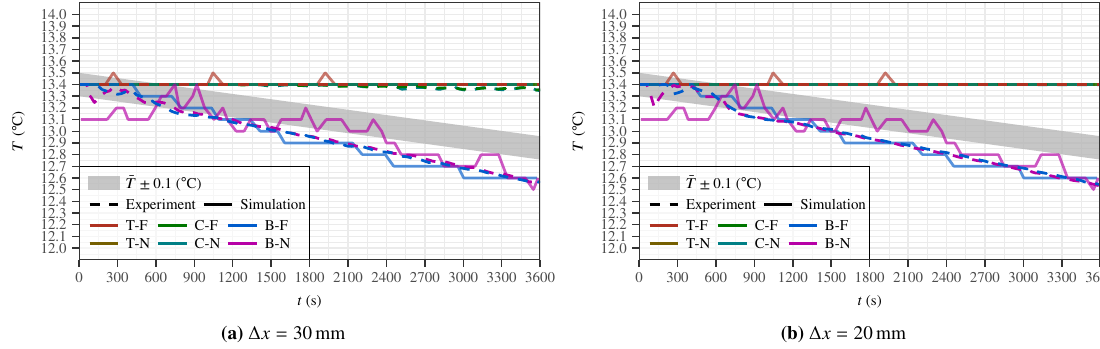
Figure 5. Comparison of experimental cooling data in the large tank with simulations, referring to six different sensor locations inside the tank and grid cell sizes of 30mm ( a ) and 20mm ( b